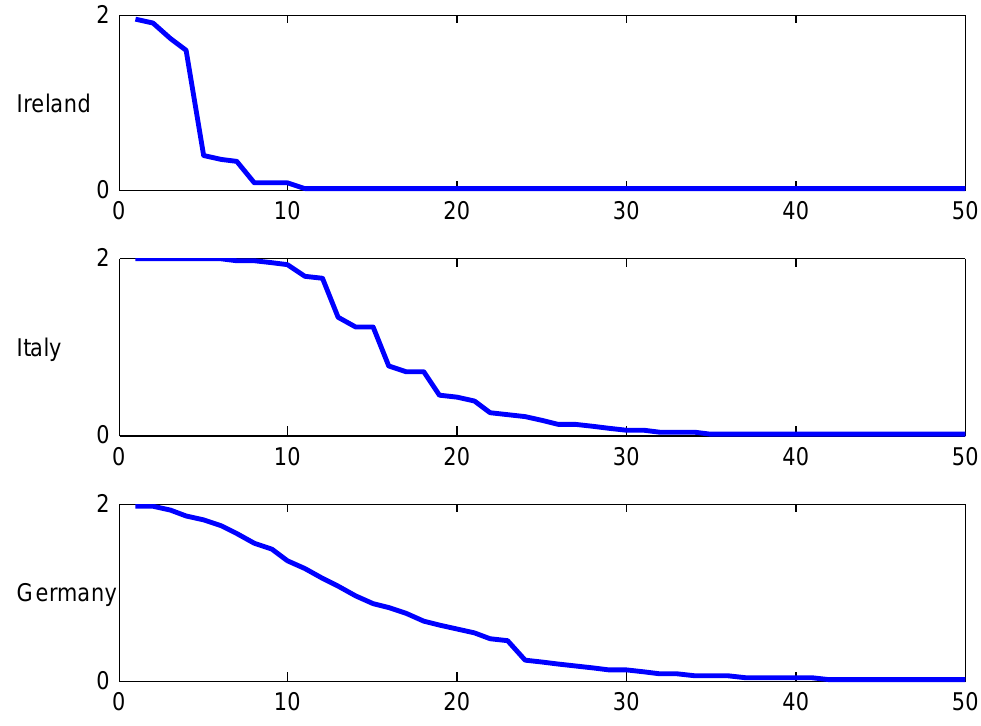
Figure 12. Population averaged convergence rates: population mean 0.1.